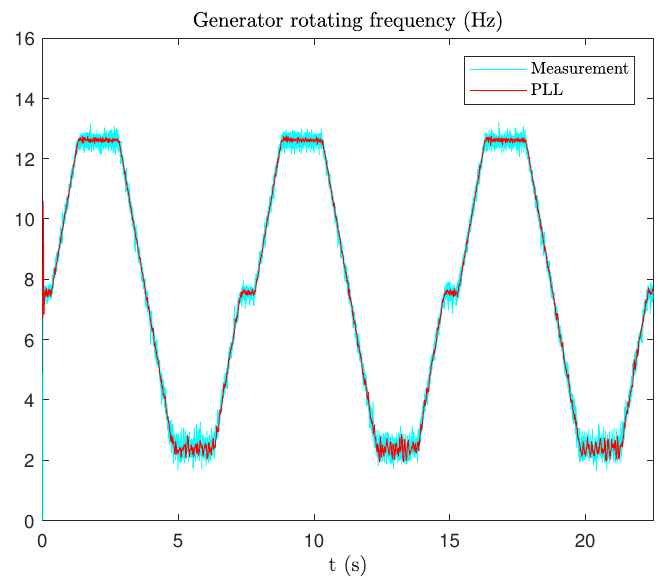
Figure 10. Estimation of rotating mechanical frequency.